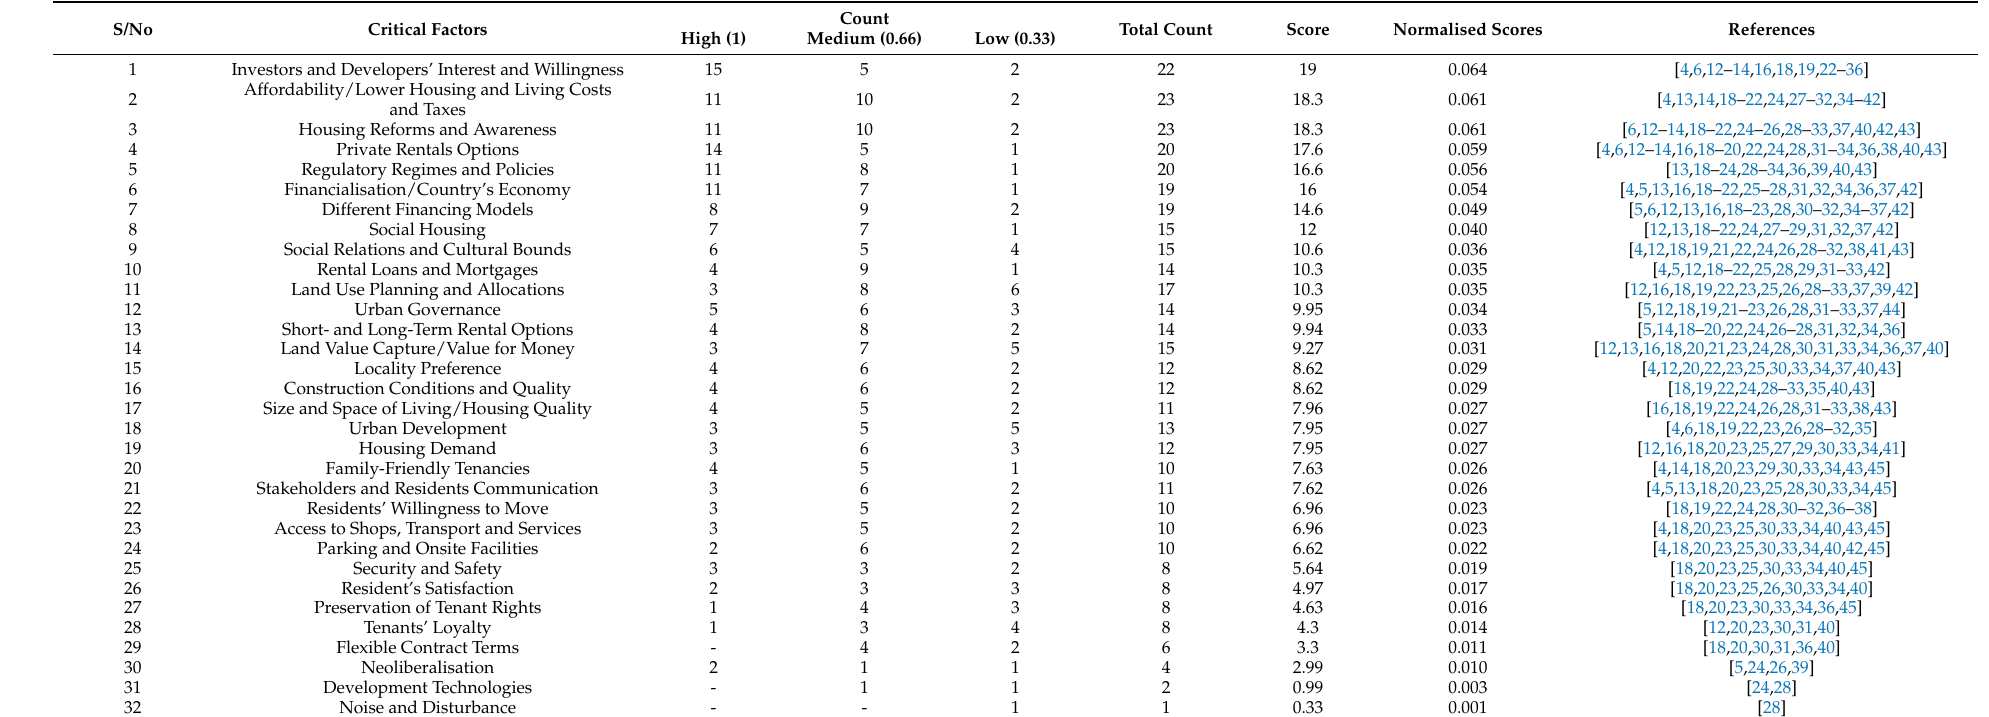
Table 10. BTR critical factors and their